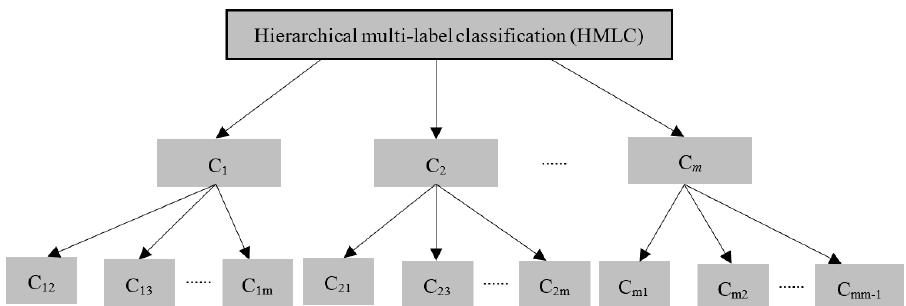
Figure 1. The structure of hierarchical multi-label classification strategy.